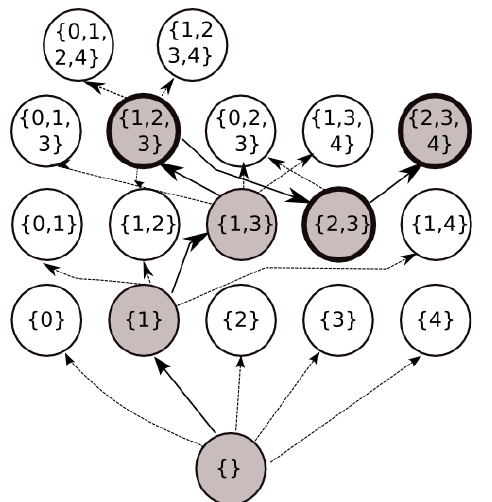
Figure 2. The fraction of the lattice that is explored by the ZZ